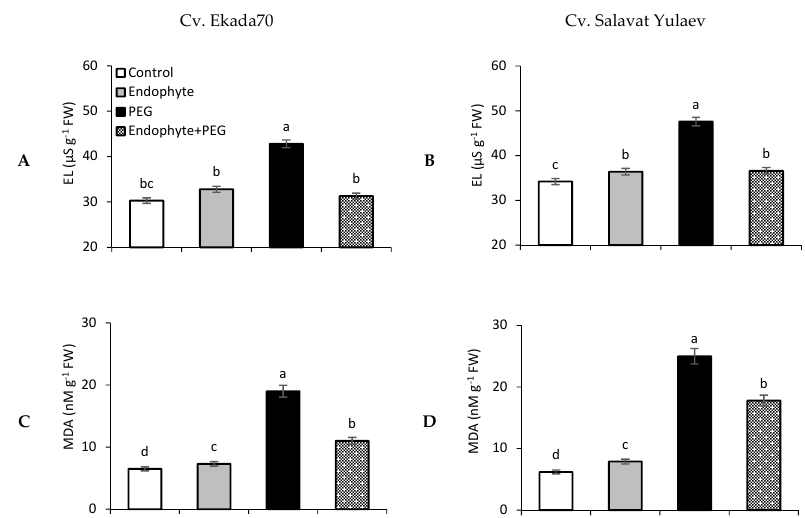
Figure 6. Changes in electrolyte leakage (EL) from six-day old seedling tissues and lipid peroxidation (malondialdehyde (MDA)) of cv. Ekada70 ( A , C ) and cv. Salavat Yulaev ( B , D ) primed before sowing with endophytic B. subtilis 10-4 (endophyte) and grown under normal and drought (24 h exposure to 12% PEG–6000) conditions. Control—non-primed plants grown under normal conditions; Endophyte—plants primed with B. subtilis 10-4 and grown under normal conditions; PEG—non-primed plants are grown under drought (12% PEG–6000); Endophyte + PEG—plants primed with B. subtilis 10-4 and grown under drought (12% PEG–6000). The bars are the means of three repetitions ± SEM. Different letters indicate a significant difference between the means at the probability level of p < 0.05.